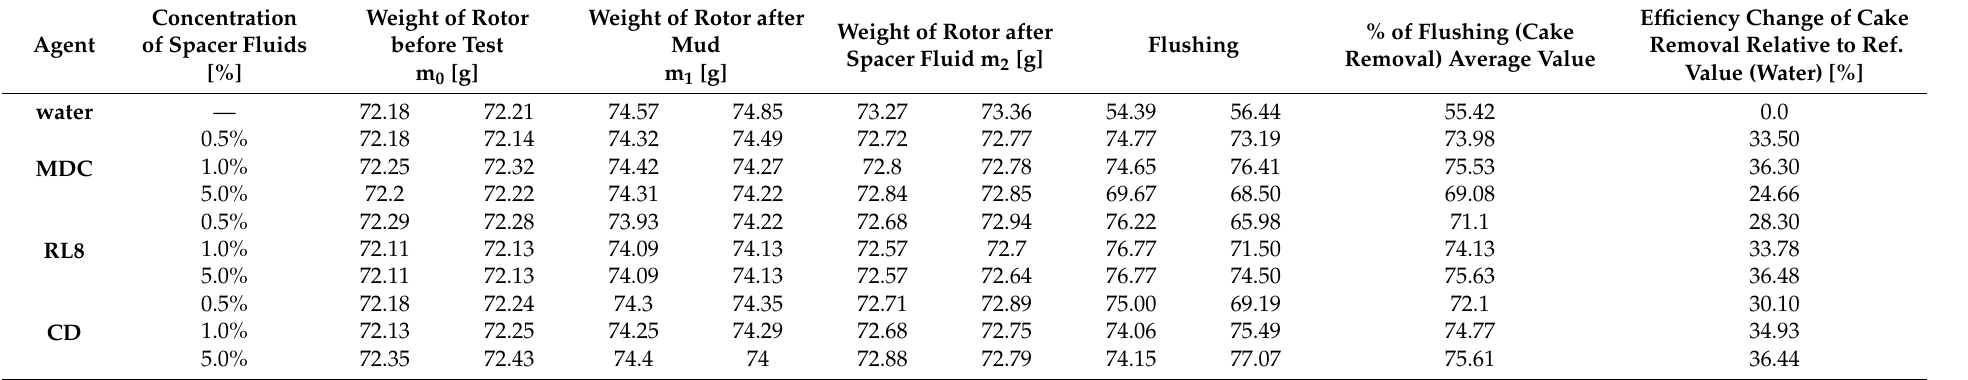
Table 1. Efficiency of mud cake removal from the rotor’s surface with traditional